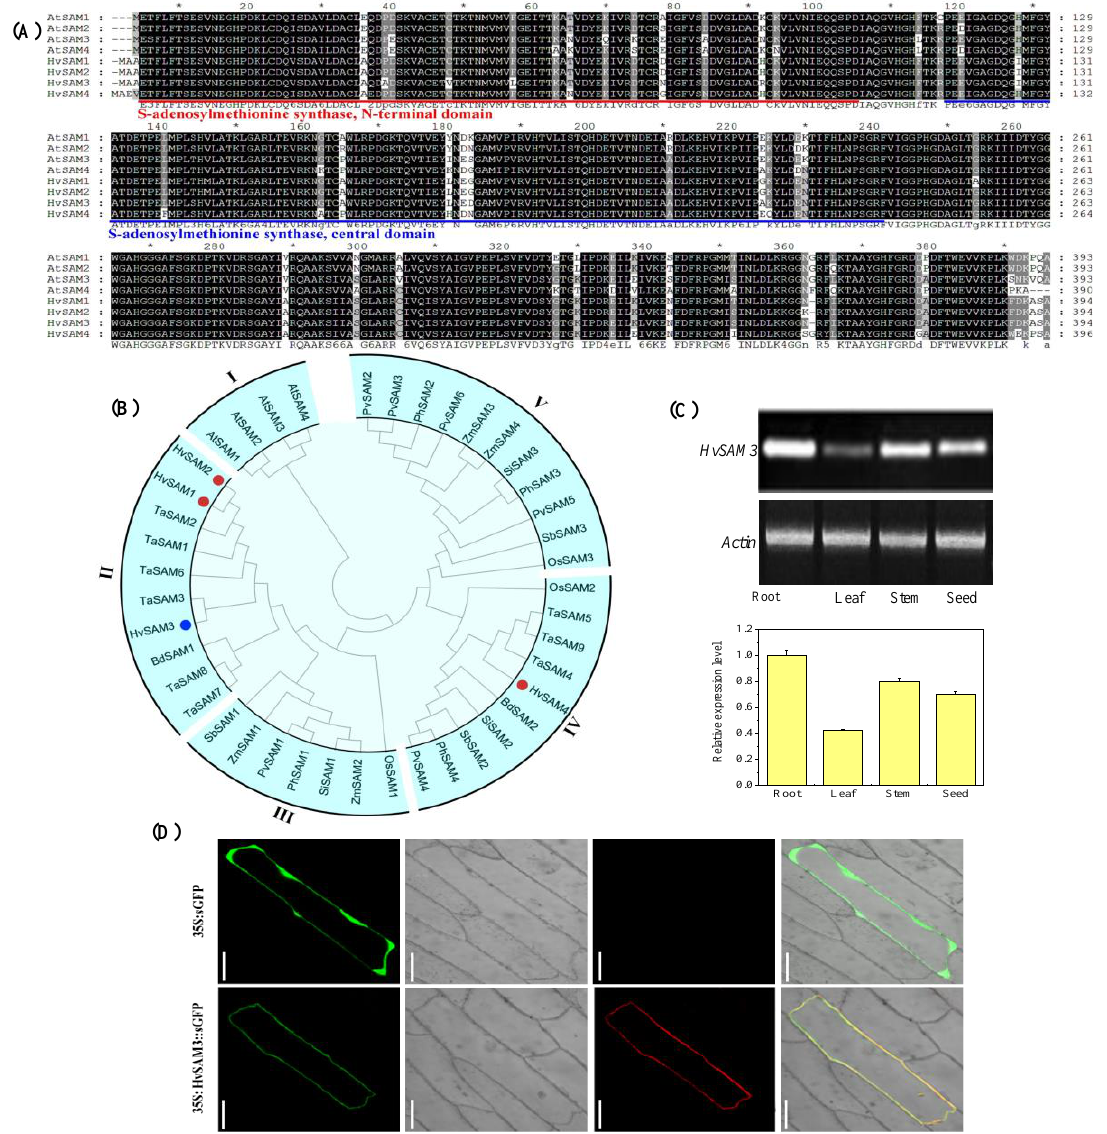
Figure 3. Identification of S-adenosylmethionine synthetase (SAM) proteins in monocots. ( A ) Multiple alignment of amino acid sequences of AtSAM1–AtSAM4 and identification of SAM in barley ( HvSAMS1–HvSAMS4 ). The conserved S-adenosylmethionine synthetase N-terminal domain and S-adenosylmethionine synthetase central domain are shown. ( B ) Phylogenetic analysis of SAM proteins in monocots. The colored dots symbolize SAM members in barley. Tissue expression pattern and subcellular localization of S-adenosylmethionine Synthetase 3 (HvSAMS3). ( C ) RT-PCR analysis of the relative transcript levels of HvSAMS3 in different tissues of XZ5. ( D ) Transient expression of GFP (Green fluorescent protein) and the HvSAMS3 -sGFP fusion protein in onion epidermis cells. Images are GFP fluorescence (GFP; green pseudocolor), red fluorescence [RFP PM marker (plasma membrane-localized marker); red pseudocolor], optical photomicrographs (bright field), and merged (optical photomicrographs, RFP PM marker, and GFP fluorescence). The data shown are representative of three independent experiments ( n = 3). Scale bars, 100 μ.